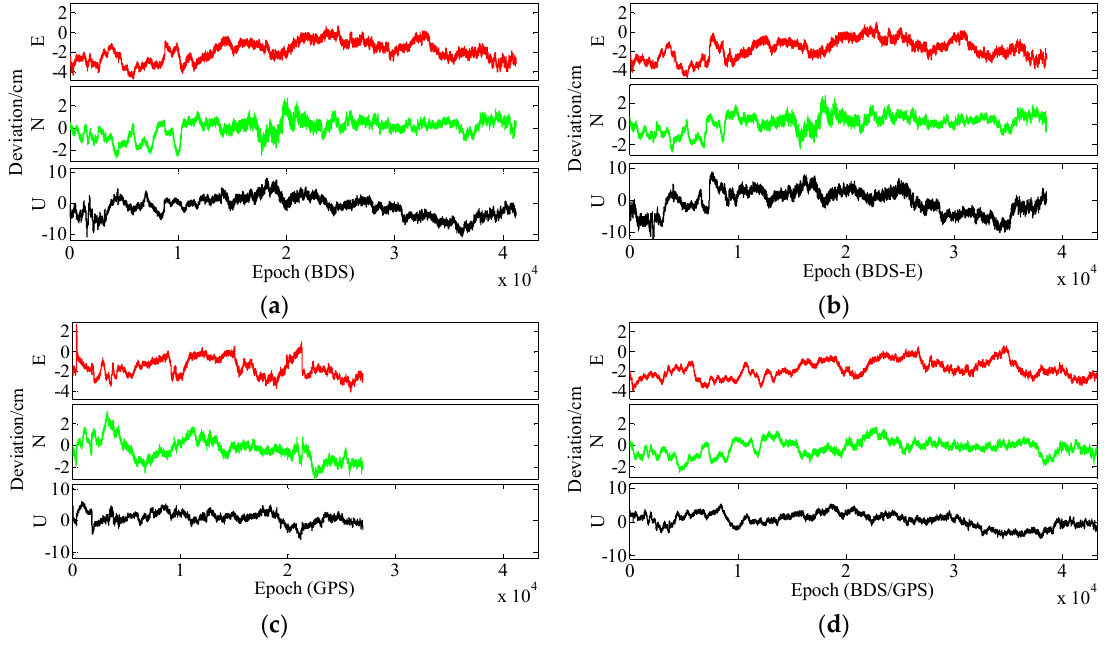
Figure 18. ENU deviations of four systems for group B. ( a ) ENU deviations of BDS for group B. ( b ) ENU deviations of BDS-E for group B. ( c ) ENU deviations of GPS for group B. ( d ) ENU deviations of BDS/GPS for group B.